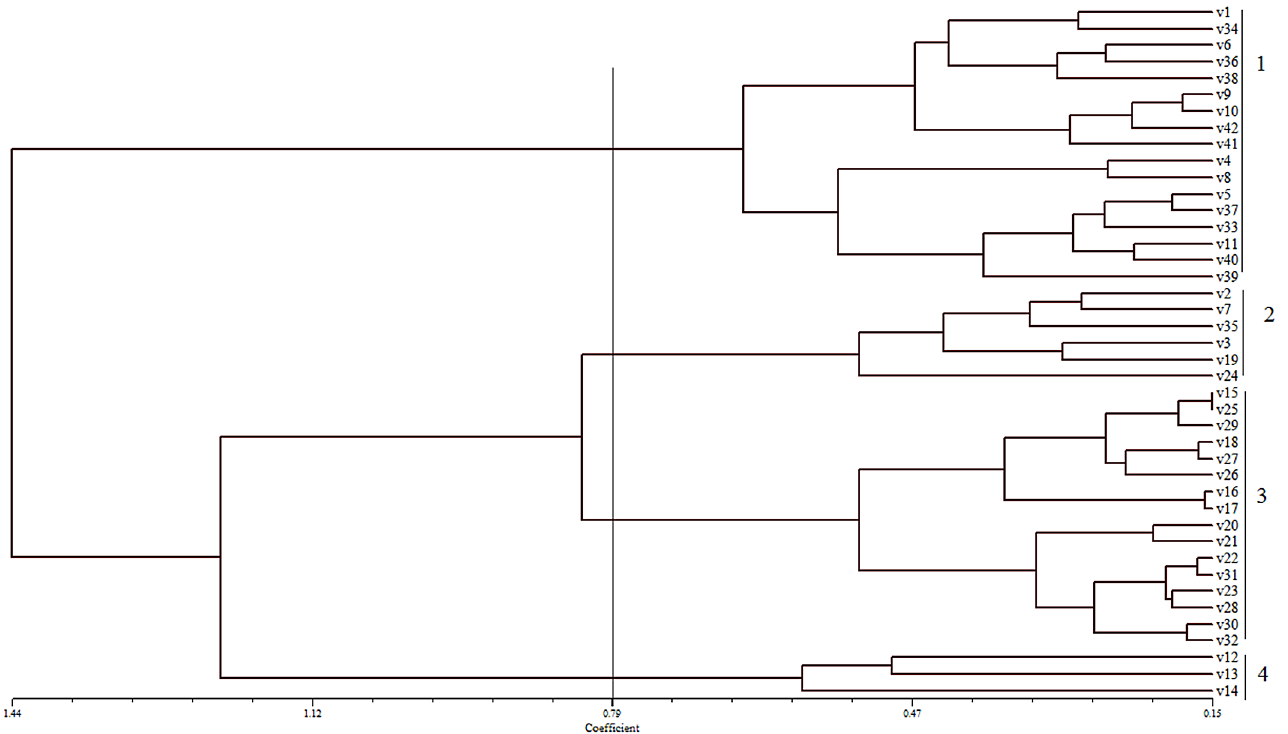
Fig 4. Dendrogram constructed from morphological and agronomic